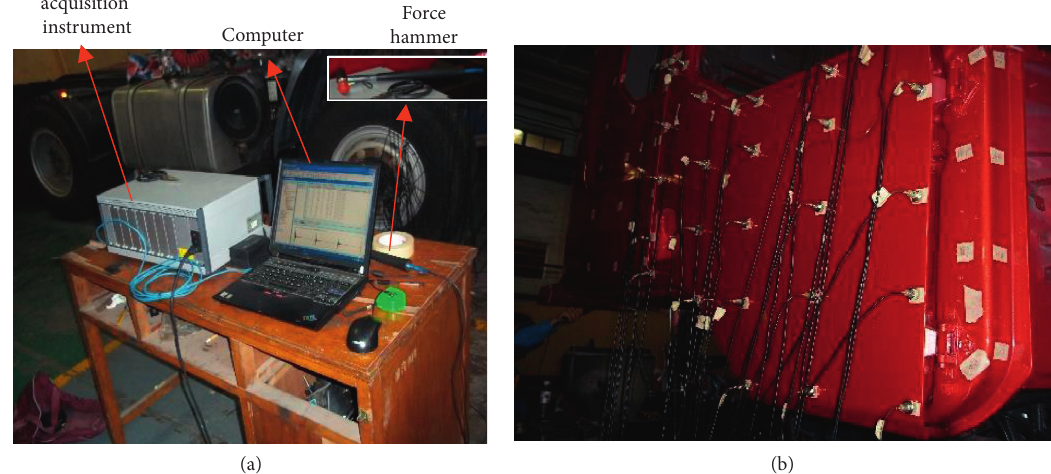
Figure 8: The experimental modal testing equipment and the location of measuring points. (a) Experimental acquisition instrument. (b) Arrangement of measuring points for cab